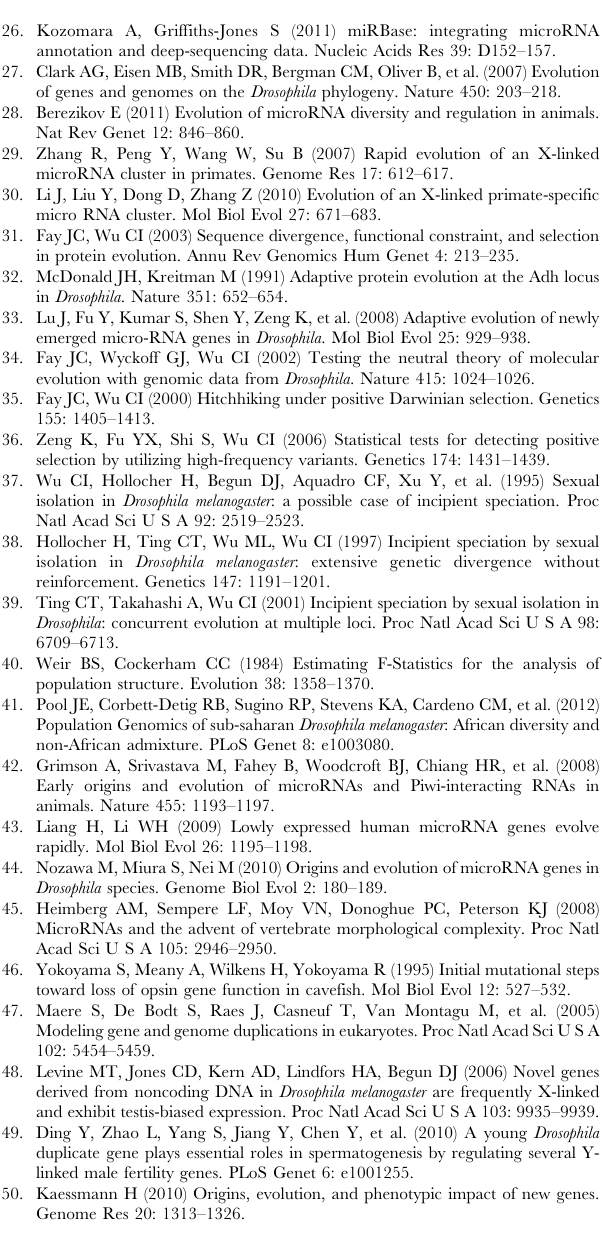
Table S8 Age and evolutionary mode of the 136 highly expressed, canonical miRNAs analyzed in this study. (PDF) Table S9 GO enrichment of the predicted target genes of miR-982s in D. melanogaster and D. simulans . Targets were predicted by seed match using TargetScan (v5.0 http://www.targetscan.org/fly_12/) [5]. (PDF) Table S10 PCR primers of the miR-982s cluster. (PDF) Text S1 Interpretation of McDonald-Kreitman test result. (PDF) Text S2 An alternative explanation for expression evolution of new and old miRNAs. (PDF)